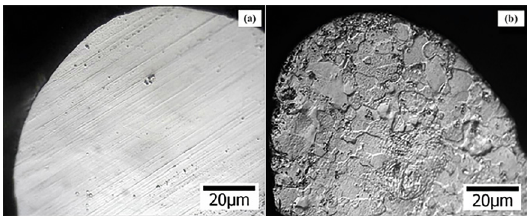
Figure 13. Optical 500x micrographs of polished zinc particles. (a) No etching, and (b) with 2 s etching. Etching reveals the cellular microstructure of the